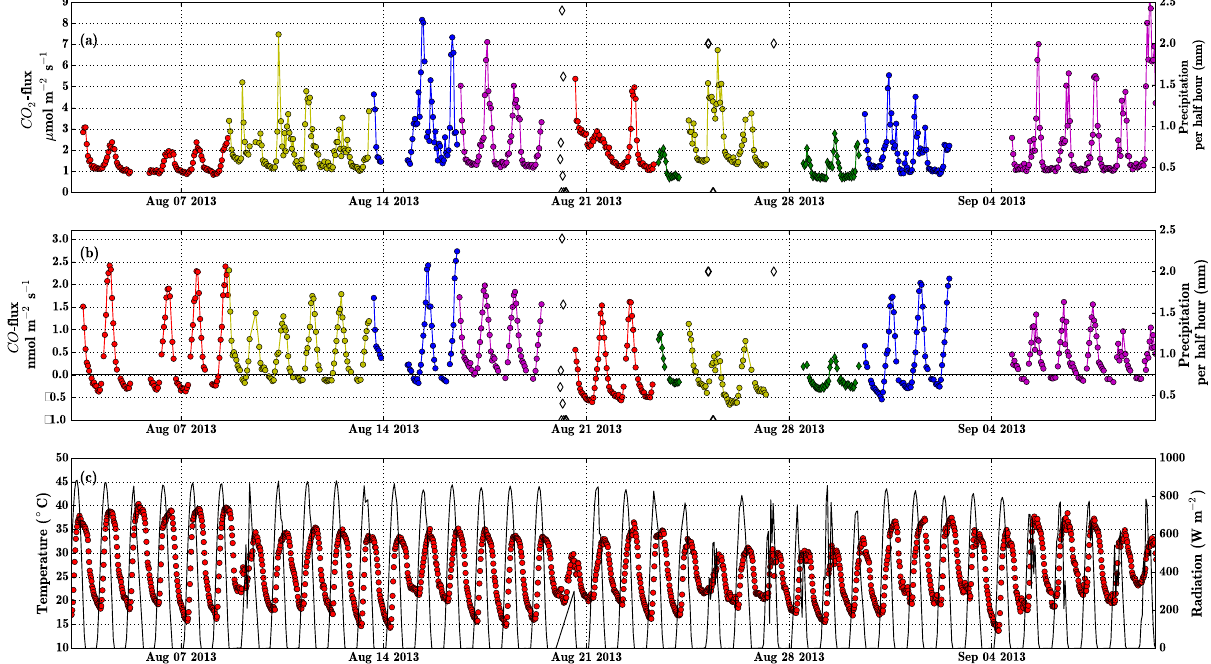
Figure 2. (a, b) Chamber CO 2 and CO fluxes (errorbars with SD of flux are included but not visible due to low value) during field experiment, different colors are different locations. The two bare soil locations (soils without organic surface material) are both presented with green diamonds. Rain events (open diamonds) are indicated. Presented data are from transparent flux chamber measurements; (c) Air temperature ( ◦ C) (red circles) and radiation (Wm − 2 ) (black